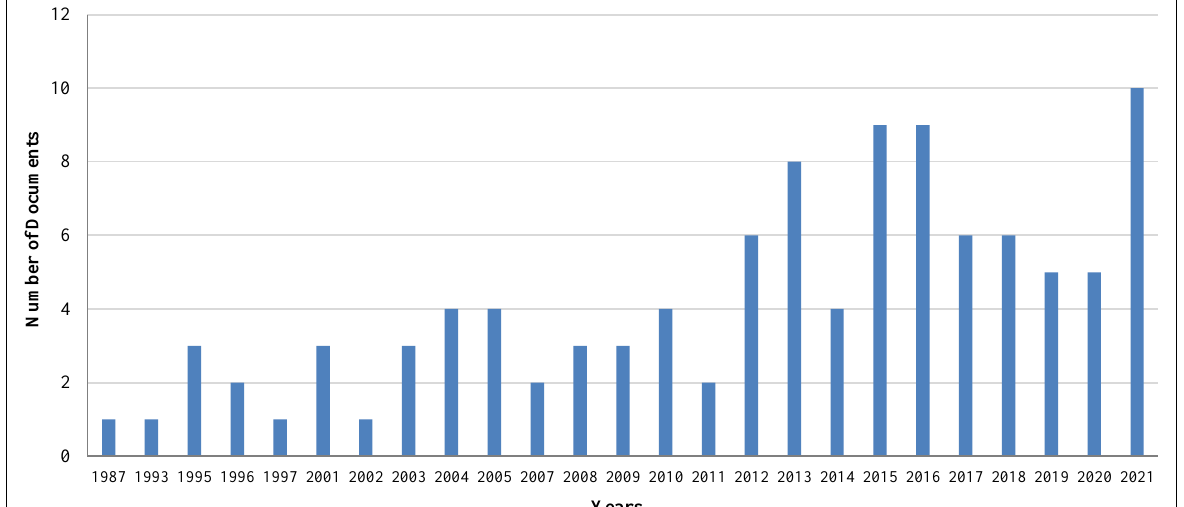
Figure 2. The number of studies per